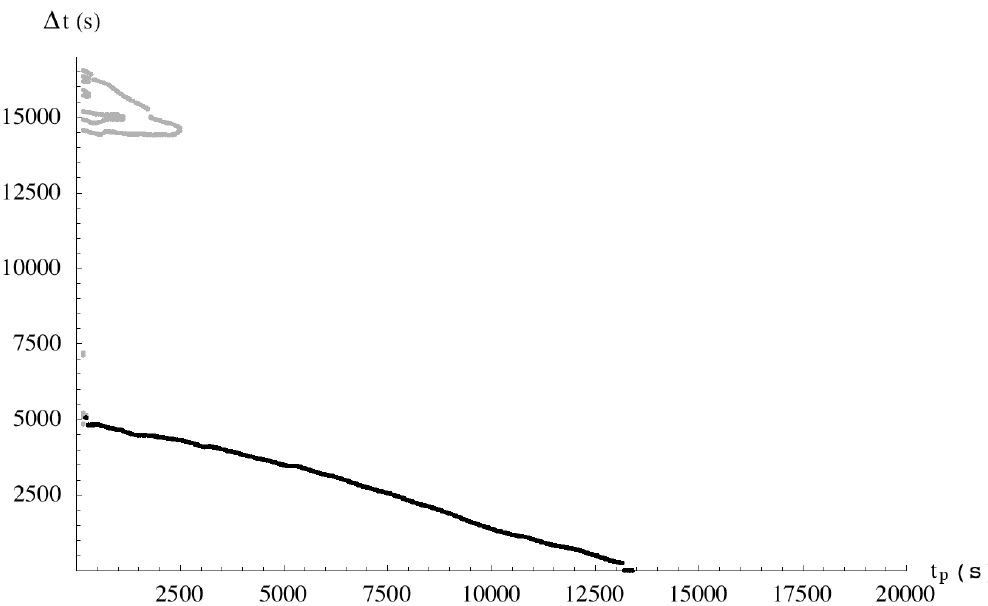
Fig. 2. Delay, 1t , of time to peak with respect to the end of the rainstorm, as a function of rainfall duration, t p , for the case study of Longo watershed (Italy), illustrated in detail Paragraph 3. 1t is a decreasing function of t p and for values t p ≥ τ c , the delay is null. For smaller t p multiple peak flows are possible. The grey points correspond to secondary peak flows and the black points to the largest peak flow.